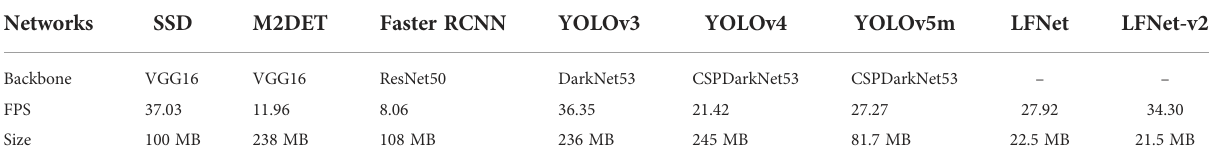
TABLE 4 Inference speed and model